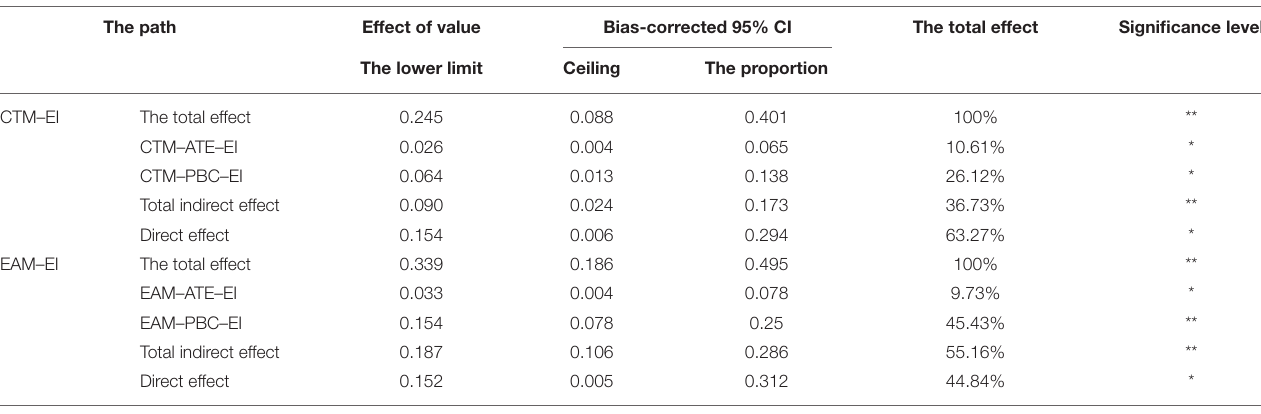
TABLE 7 | Results of mediation effect analysis. The